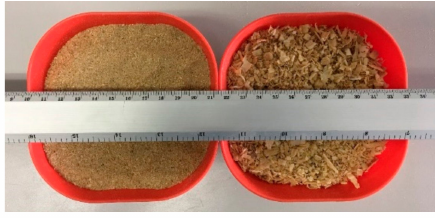
Figure 1. Sawdustandwoodshavingsusedasrawmaterialinthedevelopmentofthenewgypsumplasters.